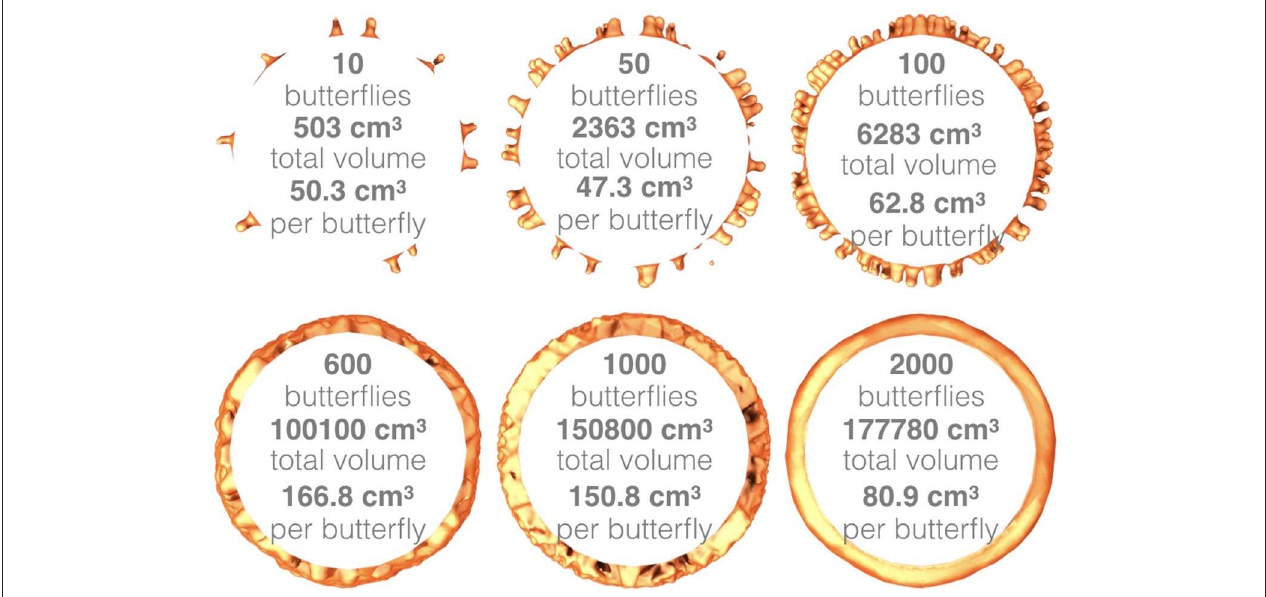
FIGURE 7 | To validate the accuracy of the TLS/SVE estimation results, clusters of different densities of butterflies were simulated in virtually, and the total volumes and the per butterfly volumes were calculated for each case. Variation in clustering behavior, density, and scanner performance can cause the per butterfly volume to vary, requiring a correction factor to account for this effect.